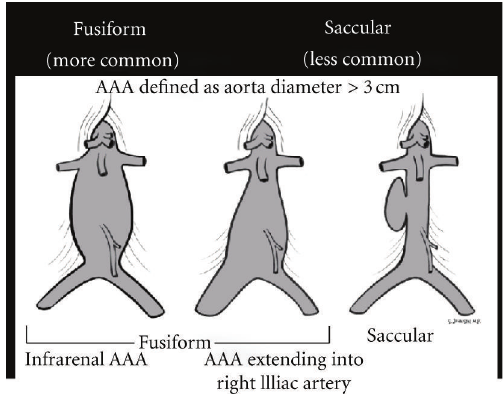
Figure 24: Abdominal aortic aneurysm (AAA) types.